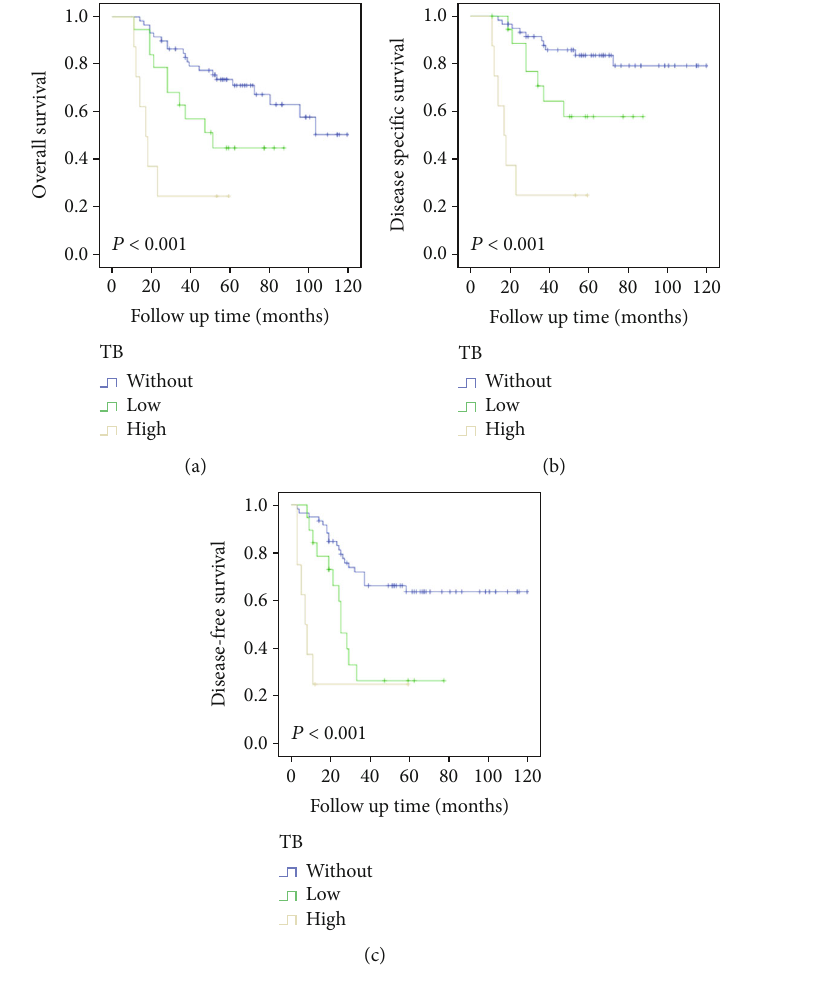
Figure 2: Association of the tumor budding with overall survival (a), disease-speci fi c survival (b), and disease-free survival (c), in ureter urothelial